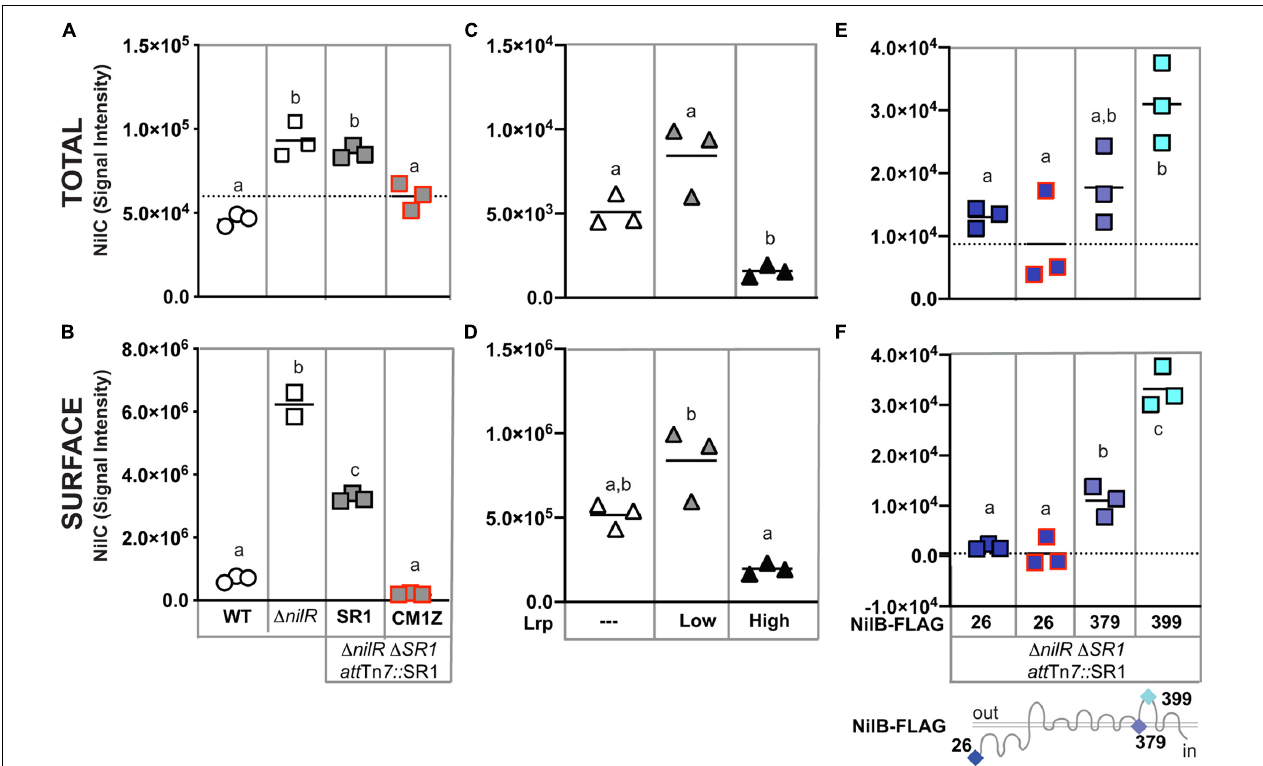
FIGURE 3 | Xenorhabdus nematophila NilC is surface exposed by NilB when its expression is de-repressed. Cell lysate (A,C,E) or whole cell (B,D,F) preparations of LB-grown X. nematophila wild type (WT, circles), (cid:49) nilR (squares), or (cid:49) lrp (triangles) strains. At the att Tn 7 site of (cid:49) nilR (cid:49) SR1 strains, wild-type SR1 (gray squares with a black outline) or SR1 with a nilCM1Z mutation (a red outline) and/or nilB -FLAG insertions (blue-shaded squares, sites of insertion noted beneath and on the NilB schematic bottom) were introduced (A,B,E,F) . (cid:49) lrp strains were transformed with a vector-only control (white triangles) or plasmids expressing low or high levels of Lrp (gray and black triangles, respectively) (C,D) . Treatments were spotted onto nitrocellulose membranes. NilC was detected by immunoblotting with anti-NilC antibodies. Significantly different groups within each panel are indicated with different letters (tested using one-way ANOVA with Tukey’s post hoc multiple comparisons analysis). Dashed axis lines indicate the mean of the nilCM1Z datapoints (A,E,F)